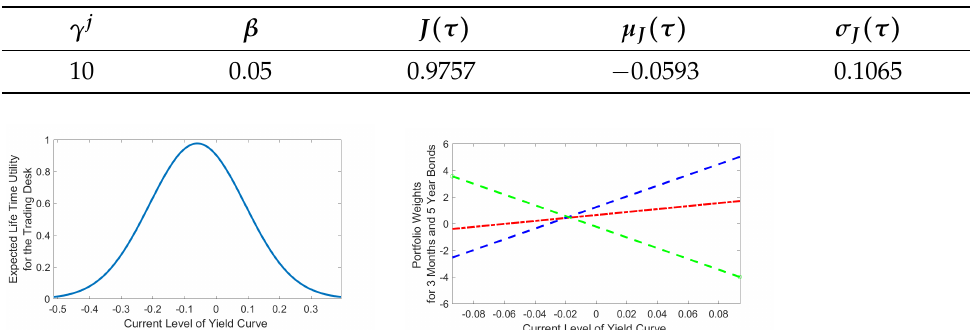
Table 4. Solution to the Lifetime Utility of the trading desk manager.